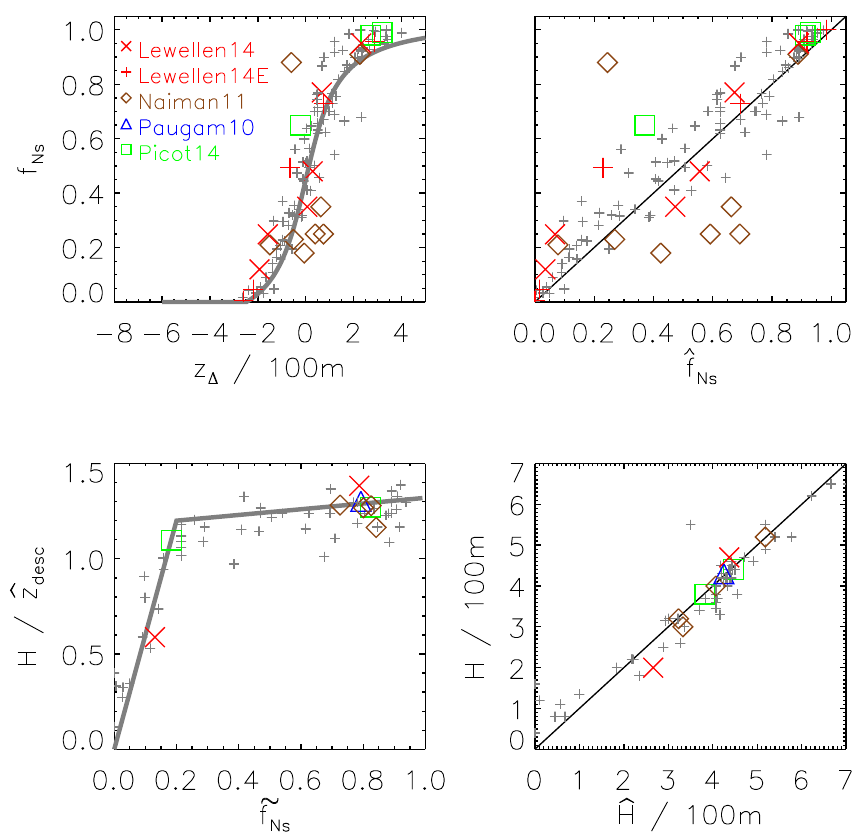
Figure 13. Top row: plot as in Fig. 5. Bottom row: plot as in Fig. 6. Grey symbols show all simulation data from Figs. 5 and 6. The coloured symbols show simulation results from other LES codes. Data are taken from Lewellen et al. (2014), Naiman et al. (2011), Paugam et al. (2010) and Picot et al.